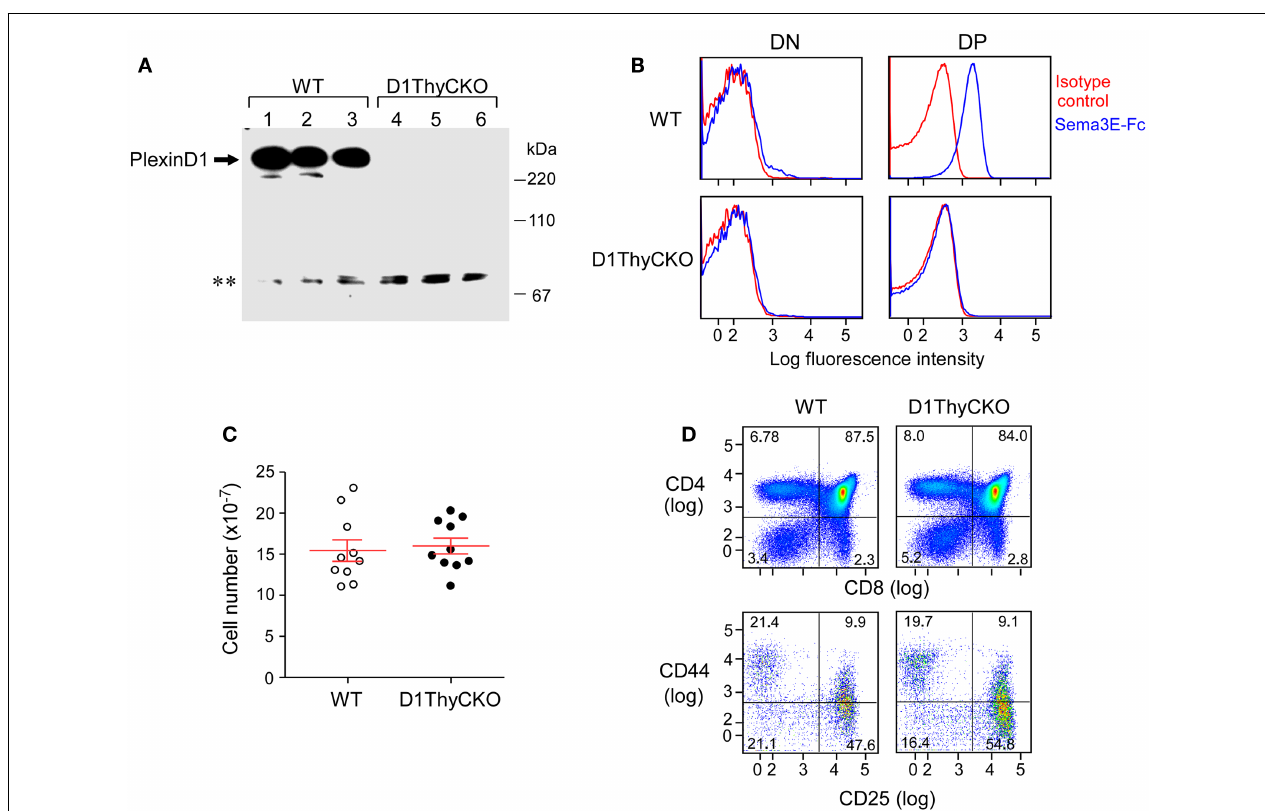
expression (representative of six independent experiments). (C) Total thymocytes/thymus fromWT or D1ThyCKO animals ( n = 10 for each strain; P = 0.737, not significant). (D) Thymocyte differentiation inWT and D1ThyCKO mice.The percentage representations of DN (CD4 − CD8 − ), DP (CD4 + CD8 +